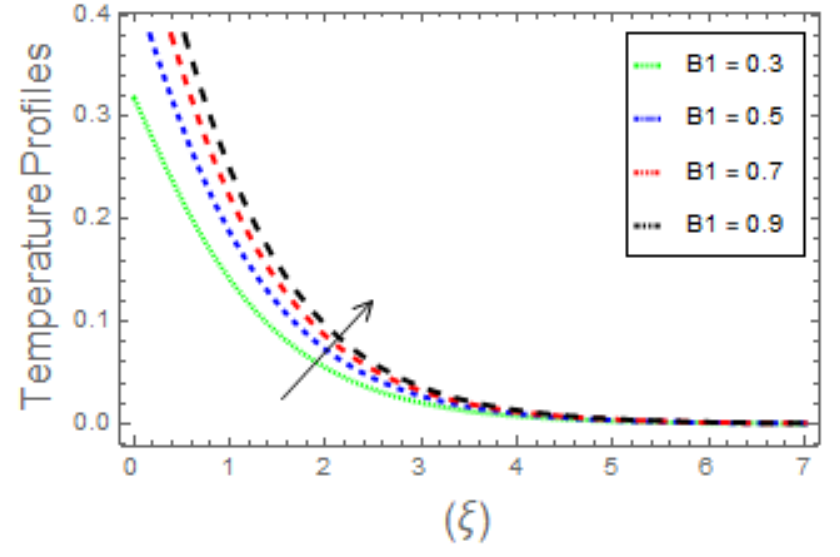
Figure 15. Variation in T due to